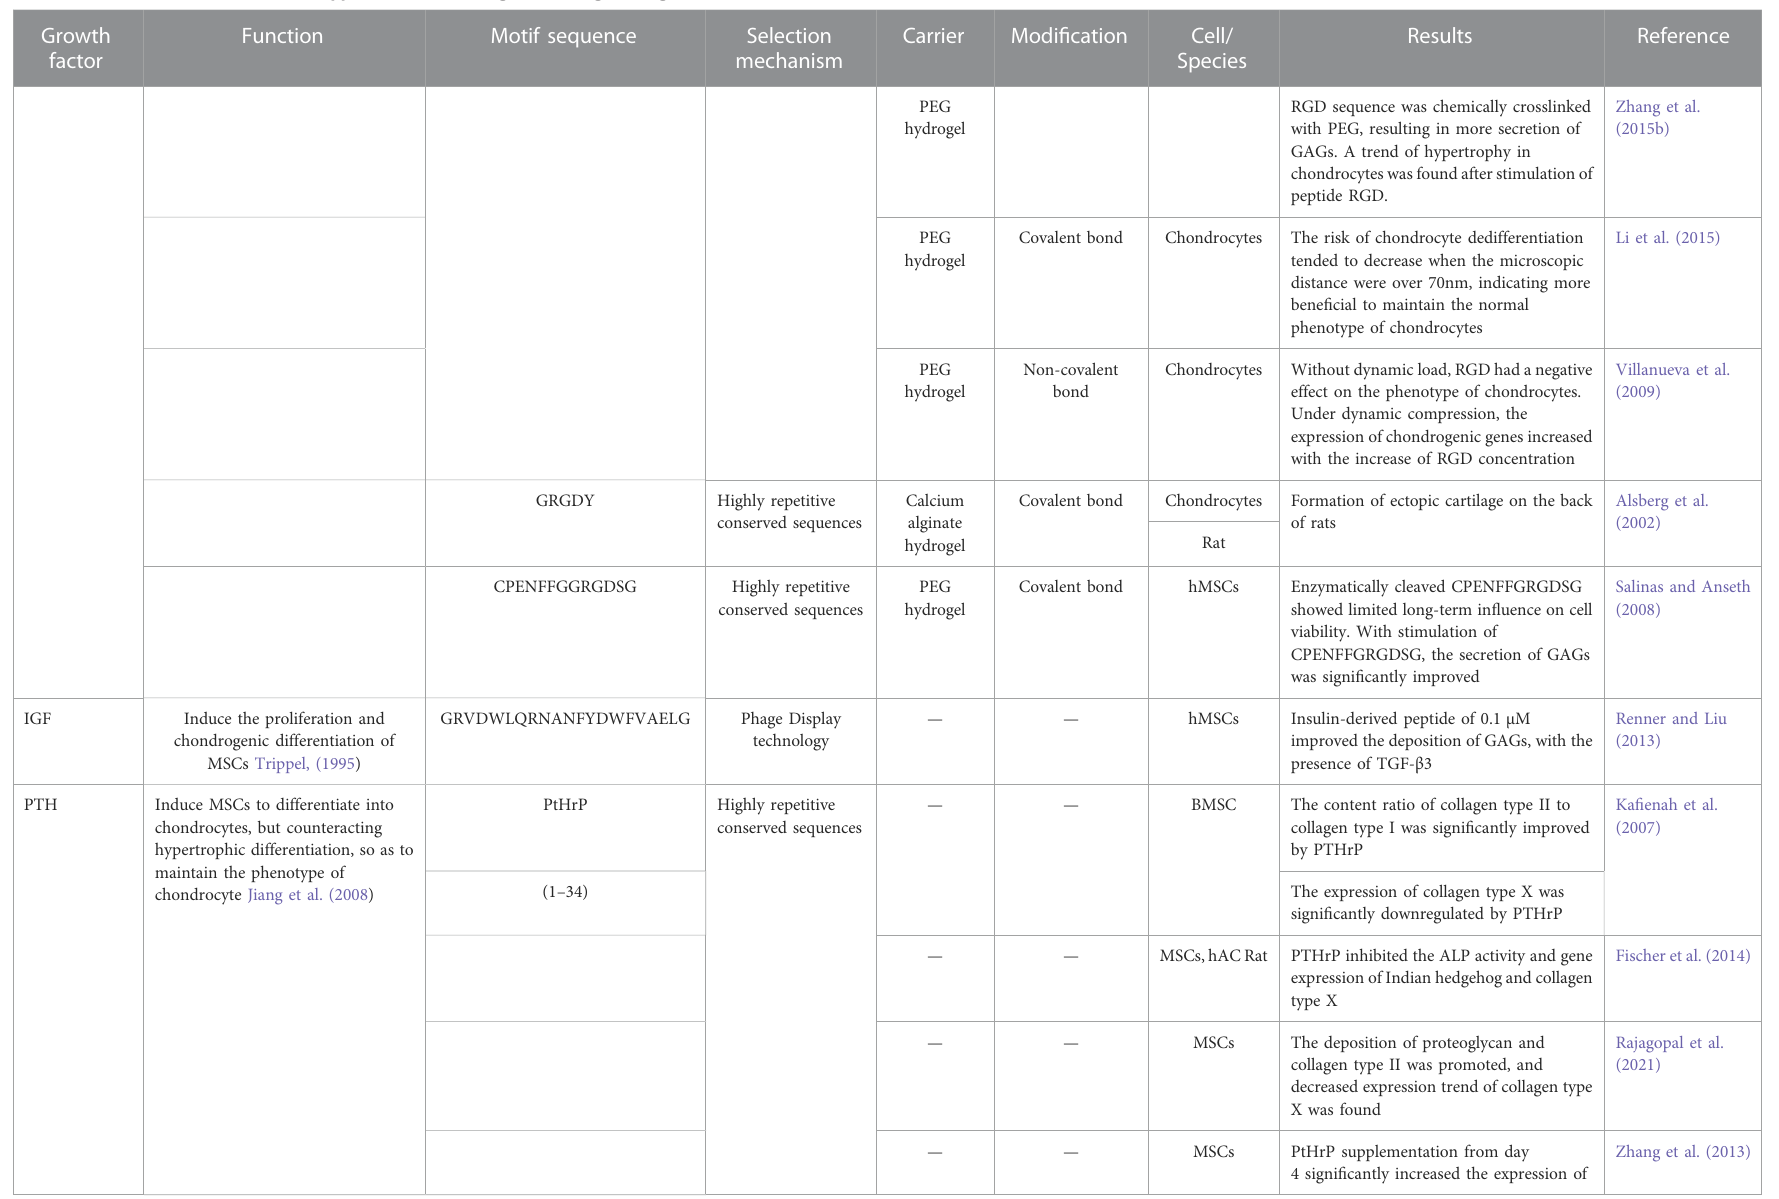
TABLE 1 ( Continued ) Functional motifs applications for cartilage tissue